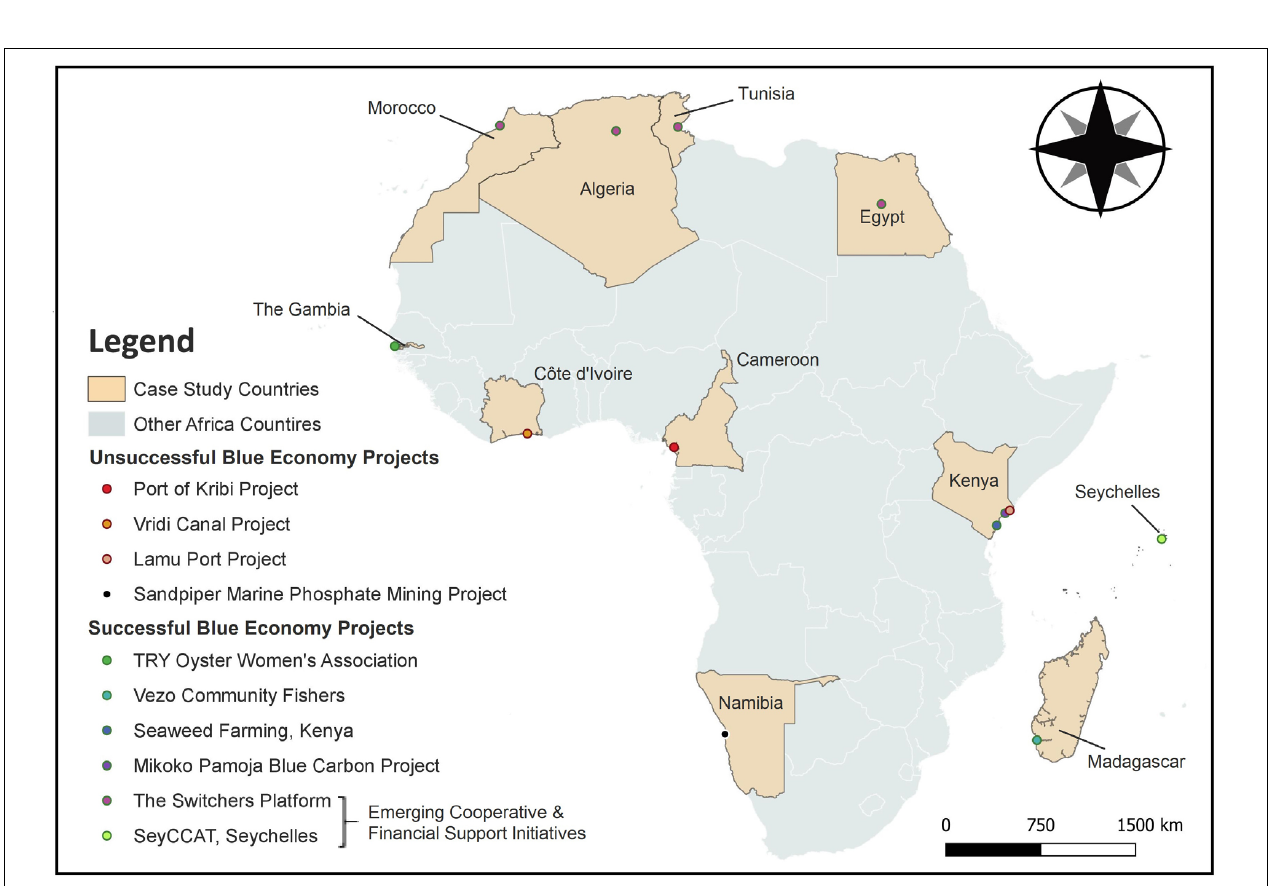
FIGURE 1 | Map of Africa, with Figure citation for the case study areas highlighted.